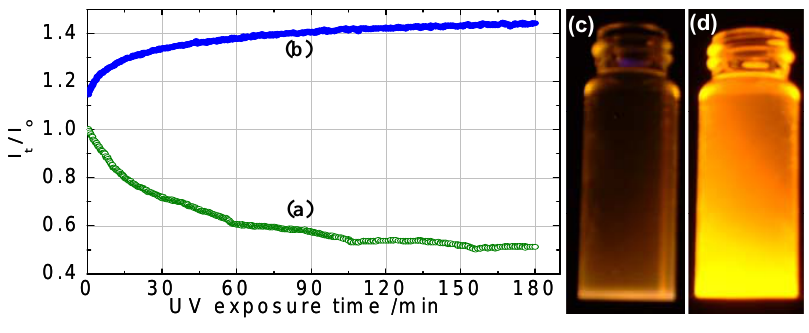
Figure 14. Variation of PL intensity in room temperature air from (a) n-dodecanethiol and (b) ZnS-passivated CdS:Mn Qdots vs. time of exposure to 400 nm UV light. The monitored wavelengths are 580 nm and 585 nm for n-dodecanthiol and ZnS passivated CdS:Mn Qdots, respectively. Comparison of relative brightness from (c) n-dodecanthiol passivation and (d) ZnS-passivated CdS:Mn Qdots under 366 nm UV-illumination [180] (reproduced by permission of The Electrochemical